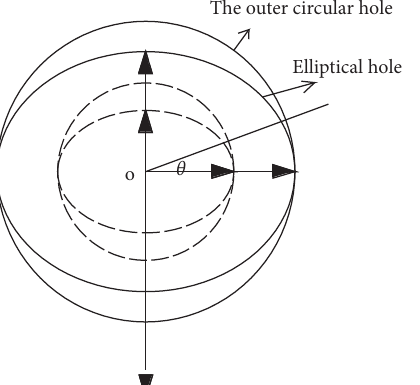
Figure 4: Current elliptical tunnel cavity and circumscribed circular tunnel cavity before and after the radial displacement at the boundary of the original tunnel cavity.